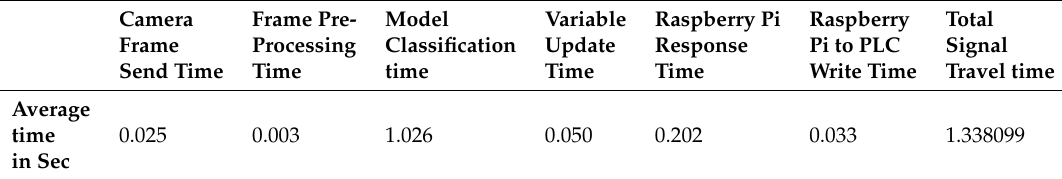
Table 2. Table of average signal travel time experiment